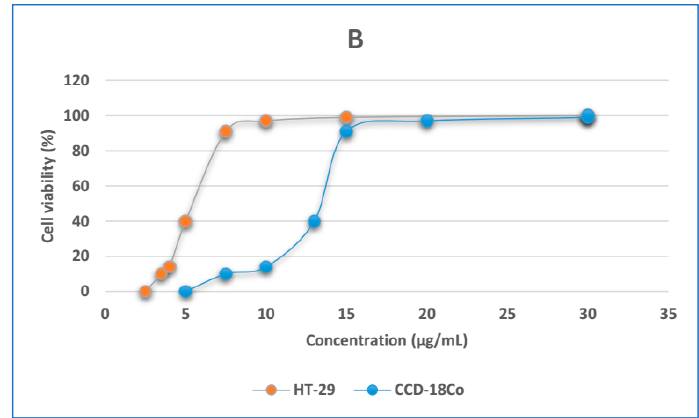
Figure 7. MTT viability assay of HT-29 cells treated with (0.5–7 µg/mL) of 5-FU and CS-FUAC conjugates, for 24 h ( A ); Dose response curves of the CS-5-FUAC on HT-29 and CCD-18Co cells in the concentration range 2.5–30 µg/mL ( B ). All values are expressed as mean ± SD (n = 3).